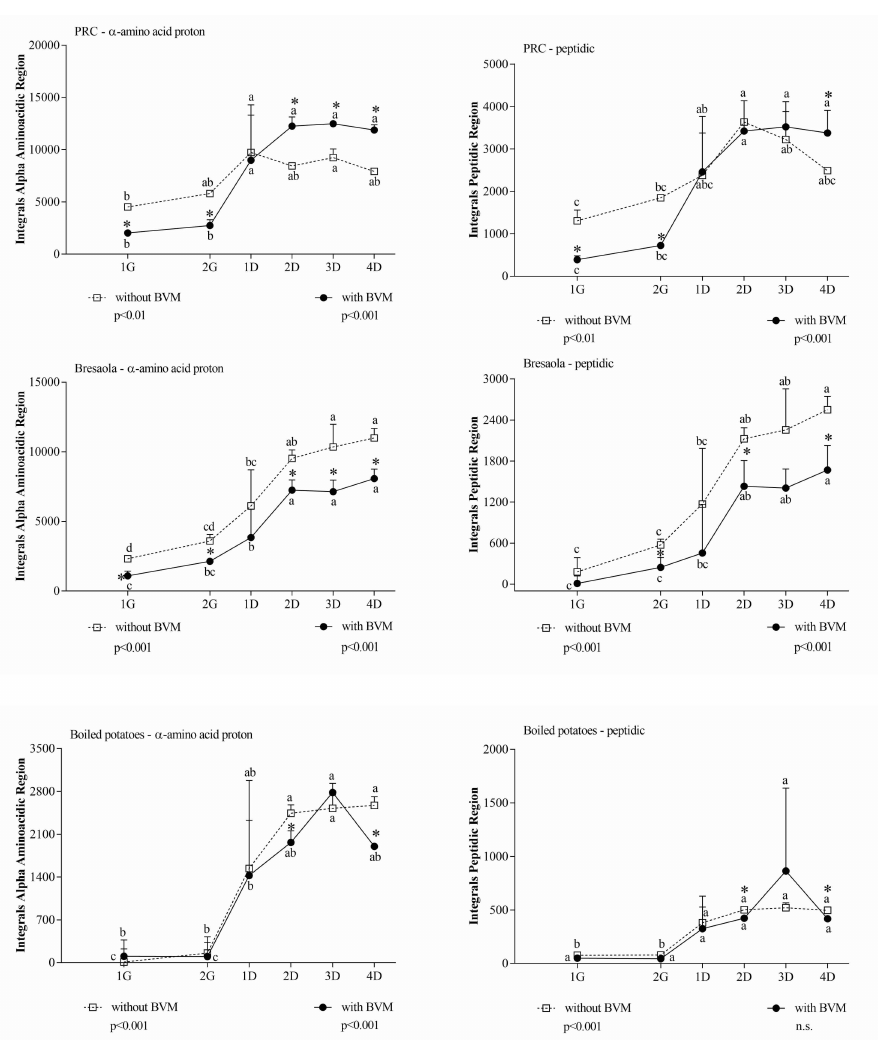
Figure 2. Integral area of α -amino acid and peptide proton regions of in vitro digested samples of PRC, Bresaola, and boiled potatoes. All data are means ± SD of at least three independent in vitro digestions. In each food matrix and spectral region, statistical analysis was by the one-way ANOVA with Tukey’s post hoc test to compare the release of soluble molecules at different time points (different letters indicate significant differences) and by the Student’s t -test to evaluate the effect of BVM at each time point (* at least p <